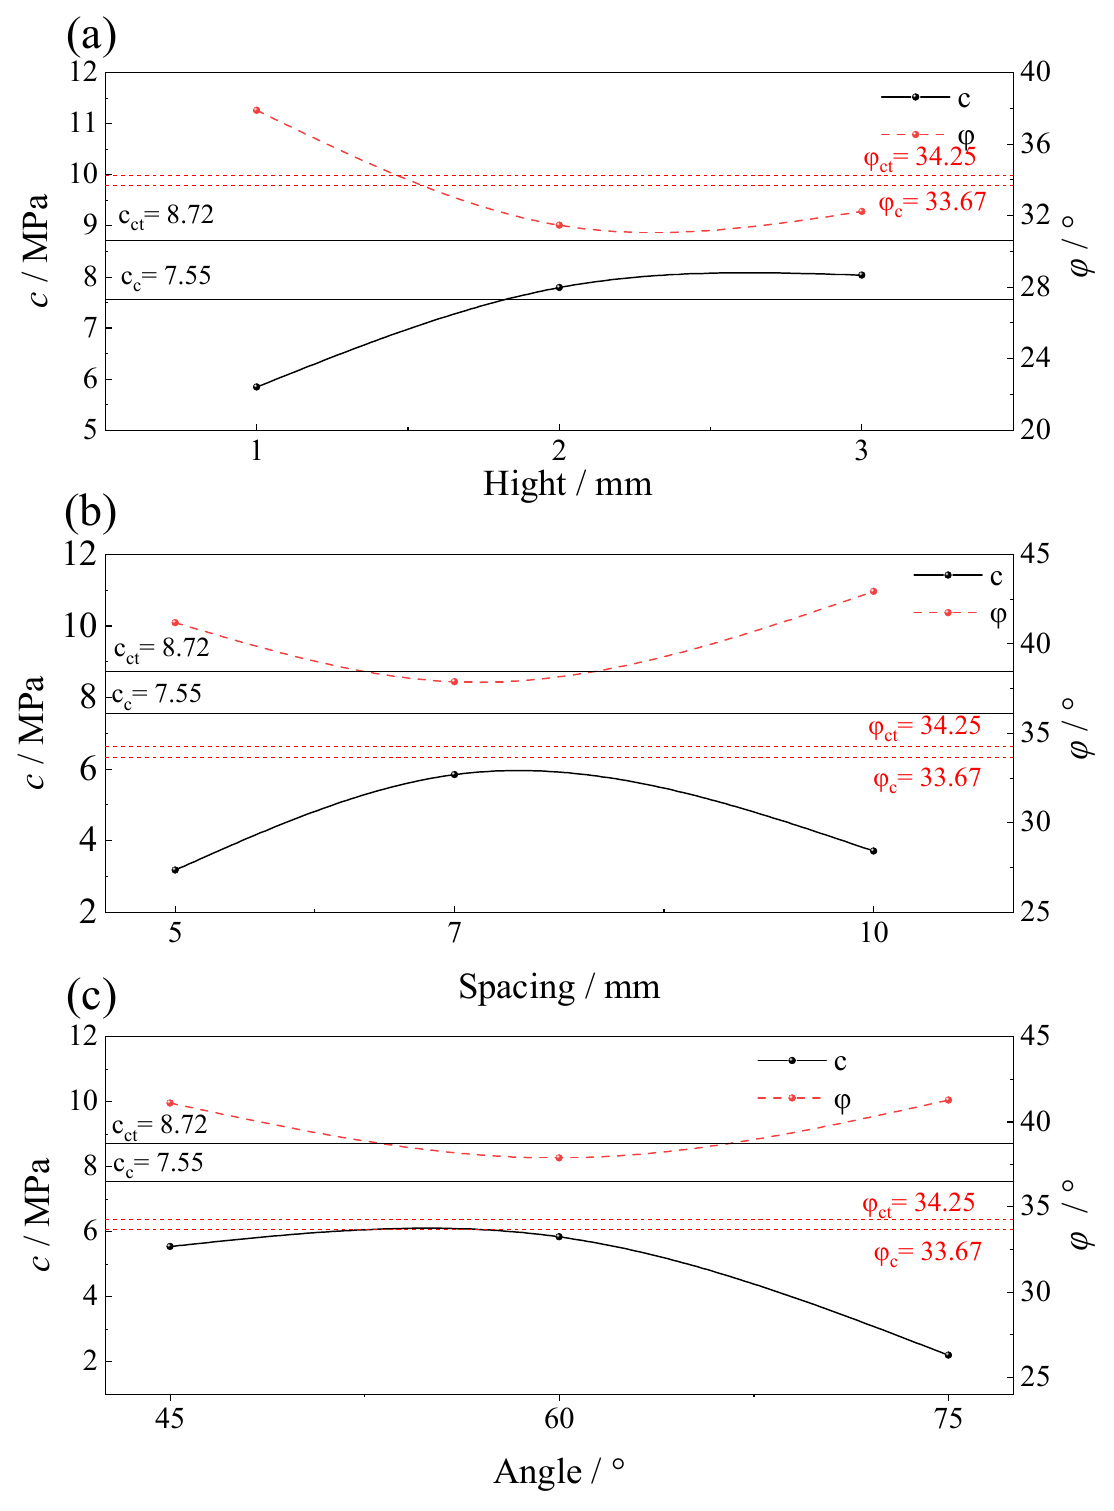
Figure 7. Influence of different tooth heights, tooth spacing and tooth angles on c, ϕ : ( a ) height ( b ) spacing ( c ) angle. Note: ϕ c and c c are measured by compression shear test, and ϕ ct and c ct are measured by conventional triaxial test.